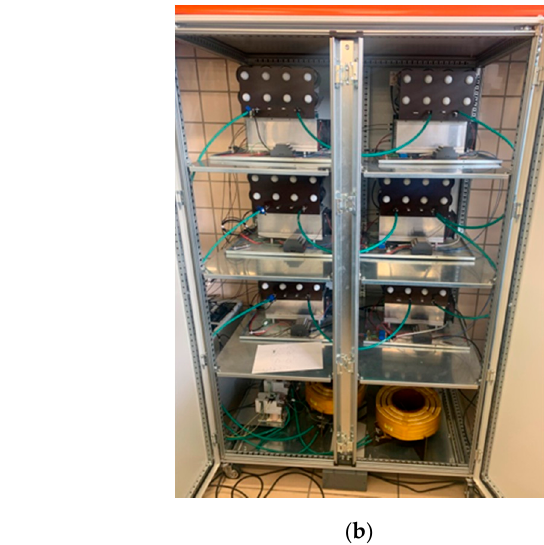
Figure 2. One individual module ( a ) and the whole converter ( b ) where the tests have been run.